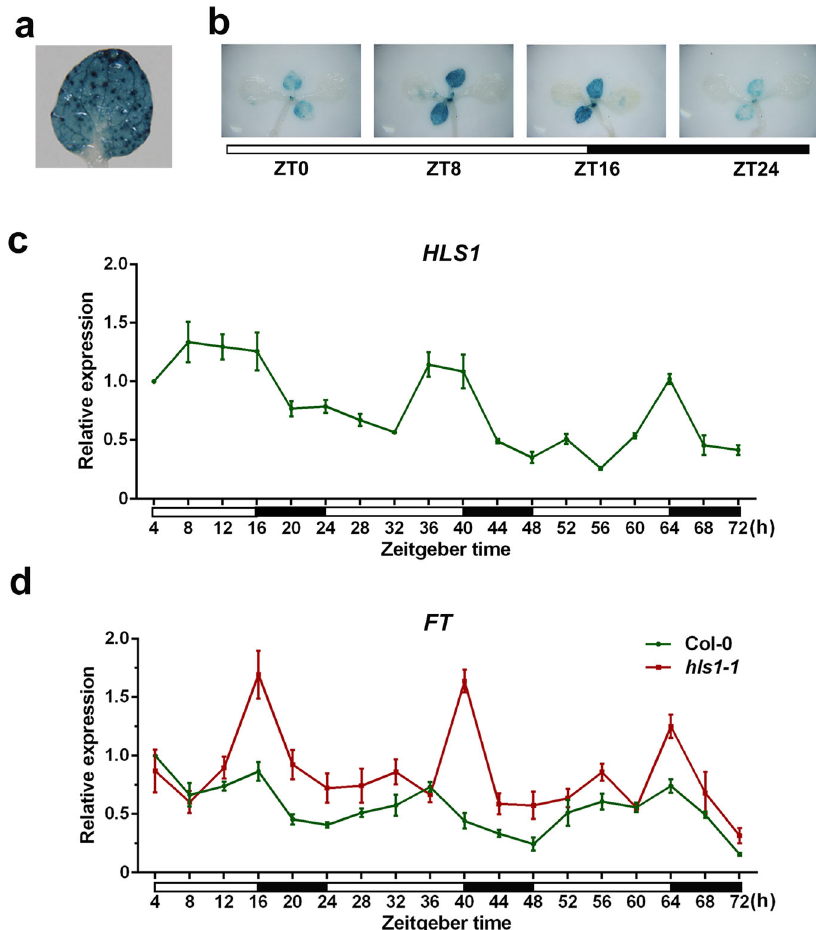
Fig. 3 HLS1 represses FT expression. a Representative image showing GUS staining in the third leaves of pHLS1 :GUS plants grown under LD for 12 days. b Representative image showing GUS staining at different Zeitgeber times in pHLS1 :GUS plants grown under LD for 12 days. White bar means daytime and black bar indicates nighttime. c qRT-PCR showing HLS1 expression in 12-day-old Col-0 plants for three consecutive days (LD). White bar means daytime and black bar indicates nighttime. Signi fi cant differences were determined by one-way analysis of variance (ANOVA) and post hoc Tukey ’ s test, data are means ± SD; n = 3. d qRT-PCR showing FT expression levels in 12-day-old plants for three consecutive days (LD). White bar means daytime and black bar indicates nighttime. Signi fi cant differences were determined by one-way analysis of variance (ANOVA) and post hoc Tukey ’ s test, data are means ± SD; n =